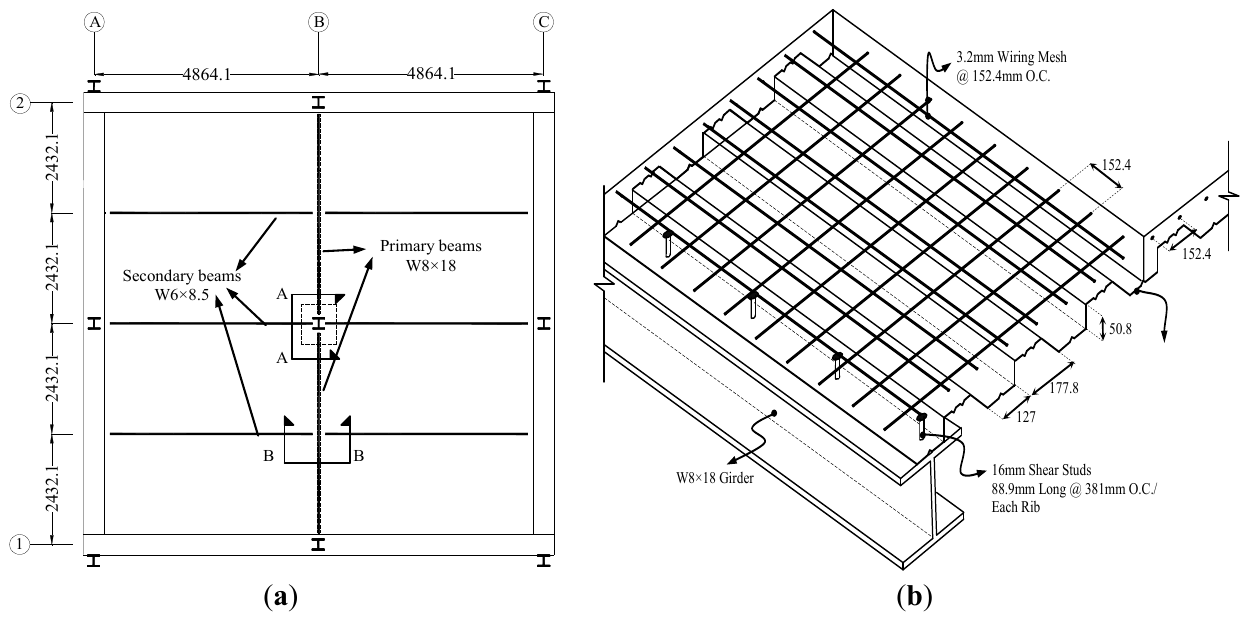
Figure 11. Test specimen. ( a ) floor plan (all dimensions in mm); ( b ) floor slab geometric configuration.